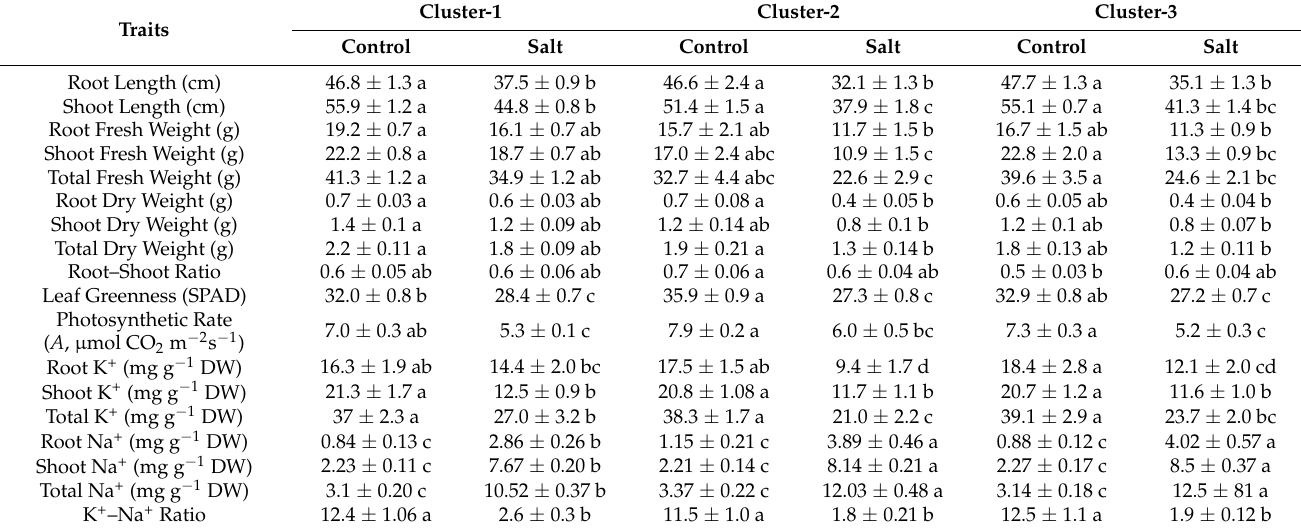
Values are mean ± SEM. Row means with different letters are significantly different at 5% levels of